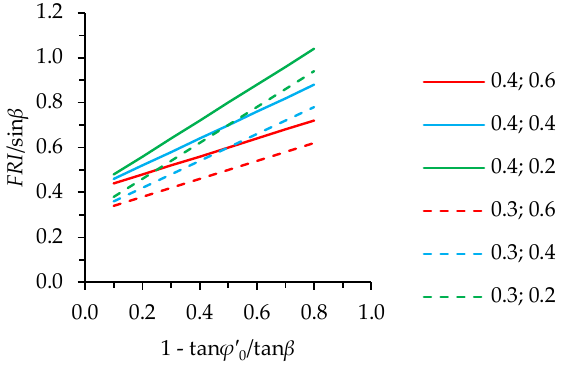
Figure 5. FRI /sin β as a function of (1 − tan φ ′ 0 /tan β ) for values of the term (tan φ ′ 0 − tan φ ′ 1 )/tan β of 0.4 and 0.3 (the first number in the legend) and for values of term c ′ 1 / c ′ 0 of 0.2, 0.4 and 0.6 (the second number in the legend).